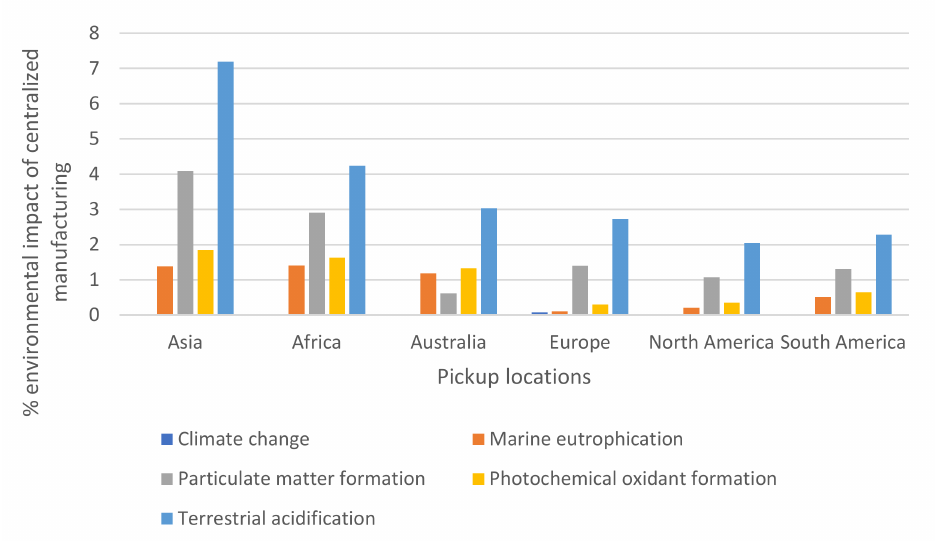
Figure 8. Comparison of environmental impact sourced from each continent for decentralized